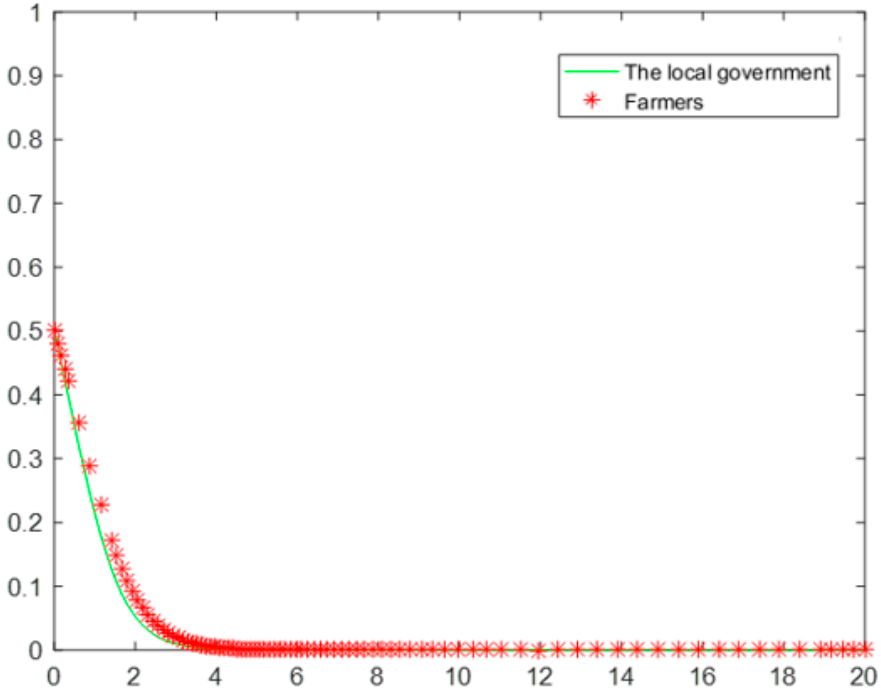
Figure 3. Evolution of strategic choice between local governments and farmers in the event of con- flict.